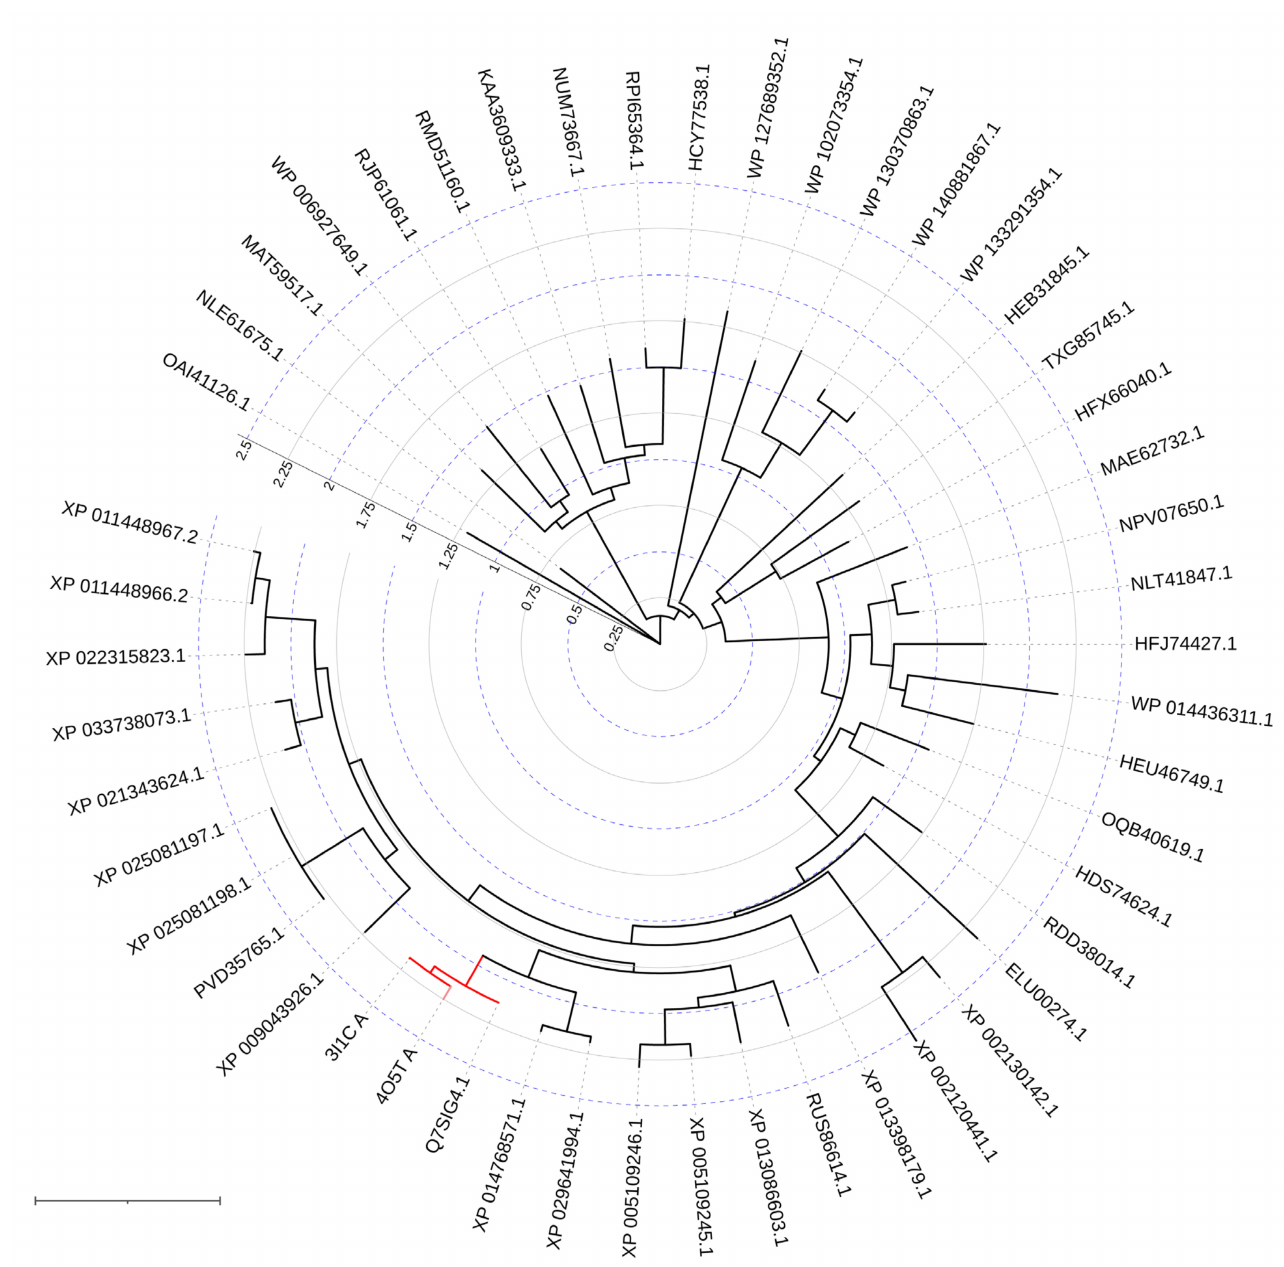
Figure 10. Phylogenetic tree of DFPase and its homologous enzymes (down to 30% identity). The tree was built as previously with PDB 2GVV as a reference sequence. Enzymes having high (90–100%) and good (80–89%) identity are highlighted with red and pink,